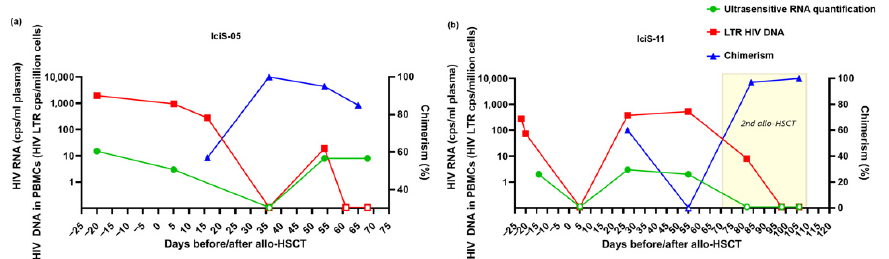
Figure 1. Clinical and virological data of IciS-05 ( a ) and IciS-11 ( b ) pre- and post-allo-HSCT. HIV-1 proviral DNA expressed as LTR DNA copies/million PBMC, and HIV-1 RNA as copies/mL for plasma and chimerism. Open symbols represent values under the level of quantification. Abbreviations: allo-HSCT, allogeneic hematopoietic stem cell transplantation. PBMCs, peripheral blood mononuclear cells. Table 2. Results of HIV-1-DNA quantification and characterization in patient IciS-05.